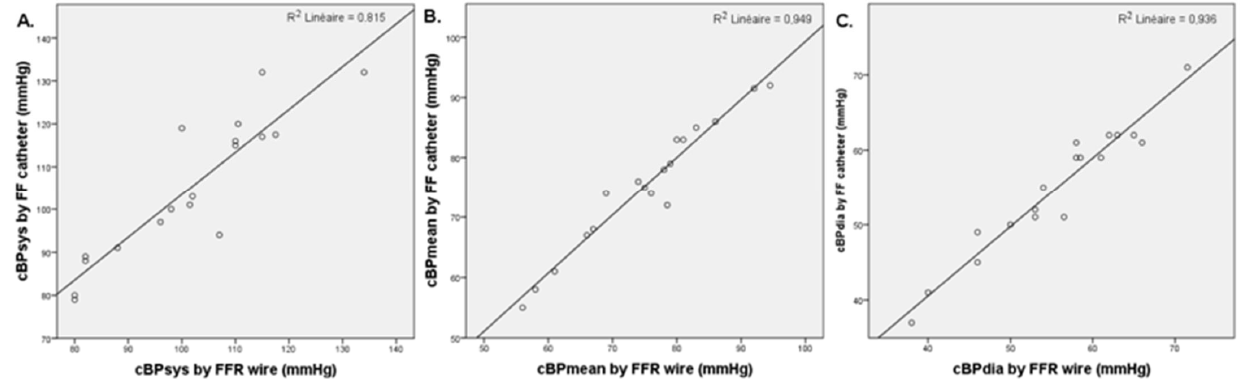
Figure 7. Correlation plot of cBPsys ( A ), cBPmean ( B ), and cBPdia ( C ) between the high ‐ fidelity measurements and the FF measurements.